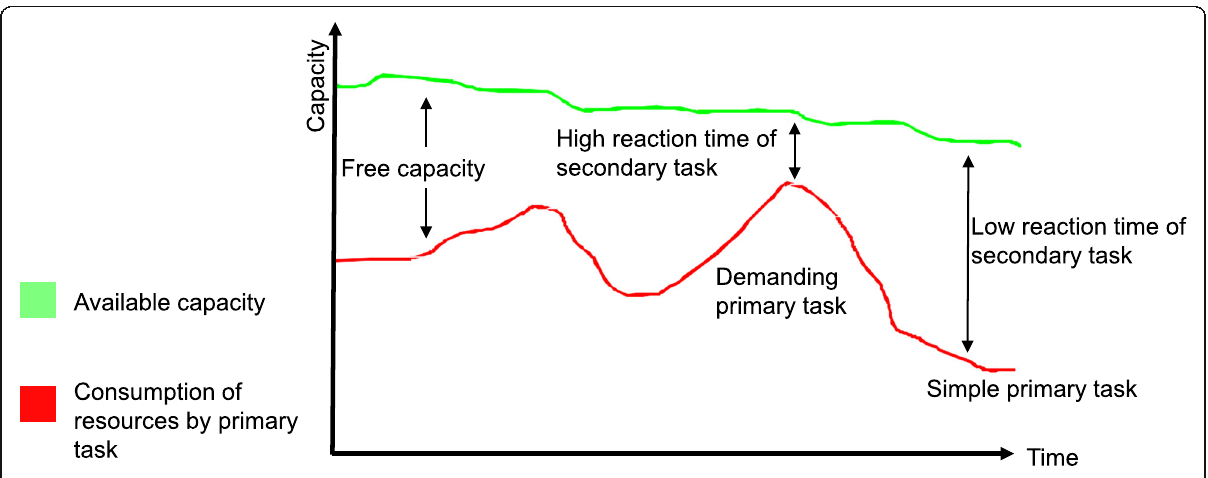
Fig. 1 The use of secondary tasks to measure spare capacity based on